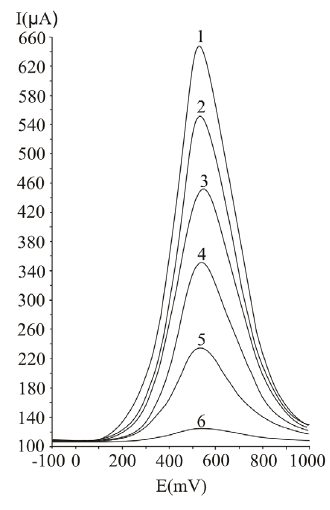
Figure 3. Influence of the pulse amplitude on the analytical response at ascorbic acid determination by differential pulse voltammetry, at a Pt working electrode; 25 mV (1), 50 mV (2), 75 mV (3), 100 mV (4), 125 mV (5) and 150 mV (6); experimental conditions: pulse amplitude 125 ms, potential scan rate 50 mV/s.